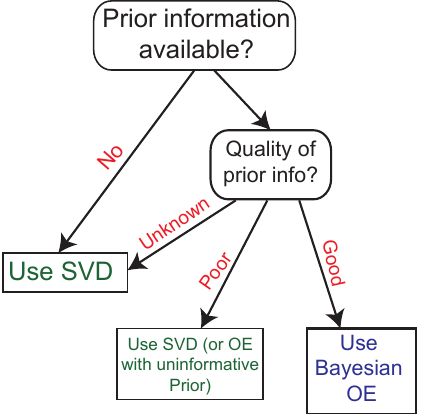
Figure 12. Decision tree for a suitable retrieval approach when the first principal component is a column mean. The quality of prior in- formation compared to the signal-to-noise ratio (SNR) determines which retrieval method would be better suited. The SVD method (with principal components retrieved) is robust and can be applied to a range of situations. However, in situations where the prior infor- mation is good (relative to the measurement SNR), the OE method offers a clear advantage of a lower variance in the retrieved X CO2